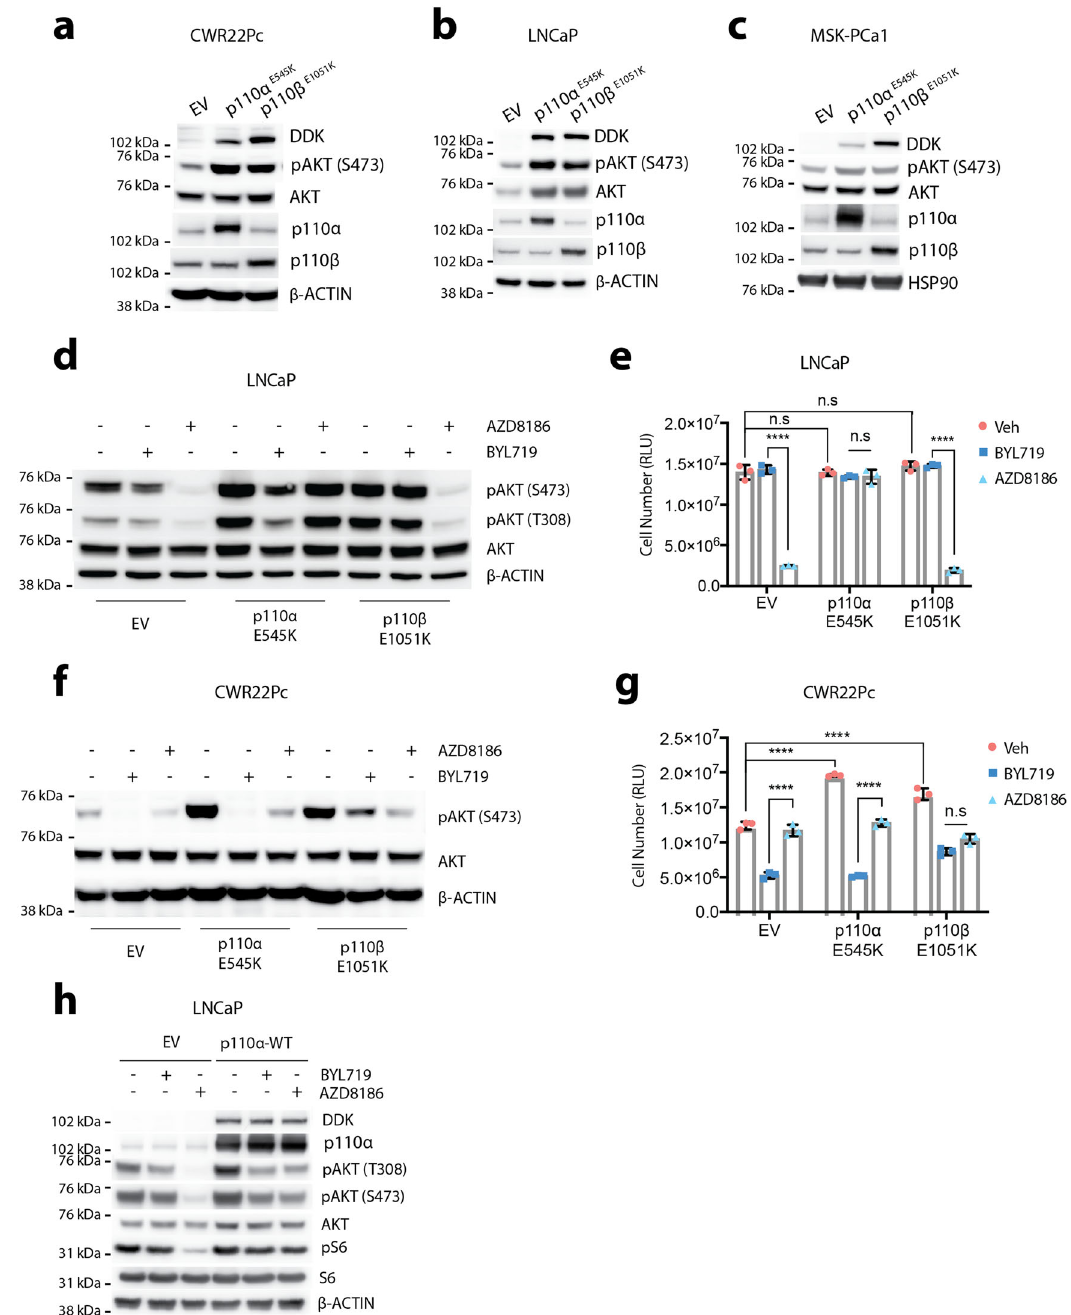
Fig. 2 Activating PIK3CA / PIK3CB mutations determine p110 isoform dependency in prostate cancer. a – c Western blot showing pAKT levels in CWR22Pc, LNCaP cells, or MSK-PCa1 organoids with ectopic expression of DDK-tagged p110 α E545K or p110 β E1051K mutants. d Western blot showing pAKT levels in LNCaP-EV, LNCaP-p110 α E545K , or LNCaP-p110 β E1051K cells treated with BYL719 (1 µ M), AZD8186 (250 nM), or Veh for 4 h. e CellTiter-Glo assay showing cell viability in LNCaP-EV, LNCaP-p110 α E545K , or LNCaP-p110 β E1051K cells treated with BYL719 (1 µ M), AZD8186 (250 nM), or Veh for 7 days. f Western blot showing pAKT levels in CWR22Pc-EV, CWR22Pc-p110 α E545K , or CWR22Pc-p110 β E1051K cells treated with BYL719 (1 µ M), AZD8186 (250 nM), or Veh for 4 h. g CellTiter-Glo assay showing cell viability in CWR22Pc-EV, CWR22Pc-p110 α E545K , or CWR22Pc-p110 β E1051K cells treated with BYL719 (1 µ M), AZD8186 (250 nM), or Veh for 7 days. h Western blot showing levels of pAKT and pS6 in LNCaP-EV (empty vector) or LNCaP-p110 α WT (ectopic expression of DDK-tagged p110 α WT ) cells cultured in regular 10% FBS-RPMI treated with BYL719 (1 µ M), AZD8186 (250 nM), or Veh for 4 h. Source data are provided as Source data fi le. All assays were performed with three biological replicates. **** p < 0.0001, n.s: not signi fi cant, e : one-way ANOVA compared to BYL719 group, g : one-way ANOVA compared to AZD8186 group, error bar represents mean values± SD.